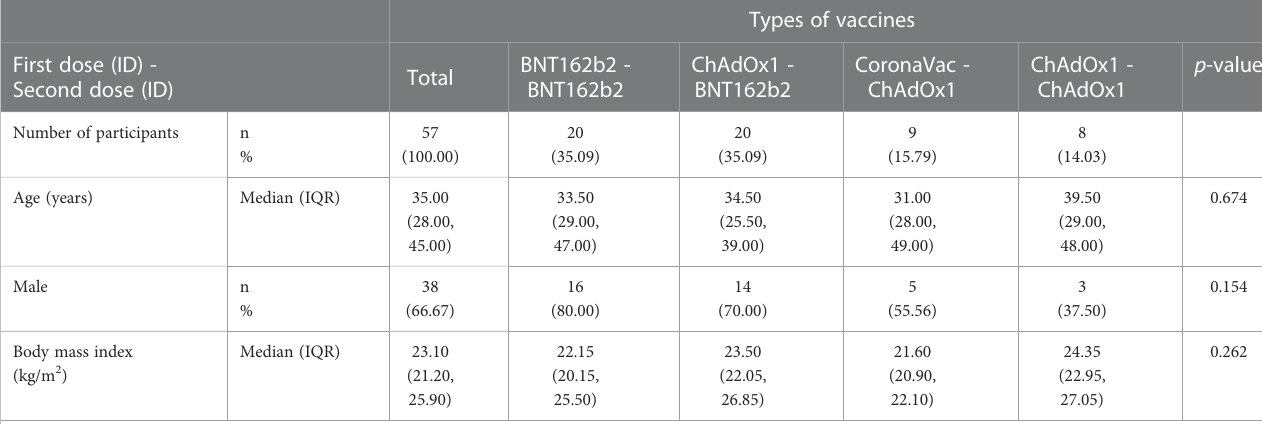
Types of vaccines